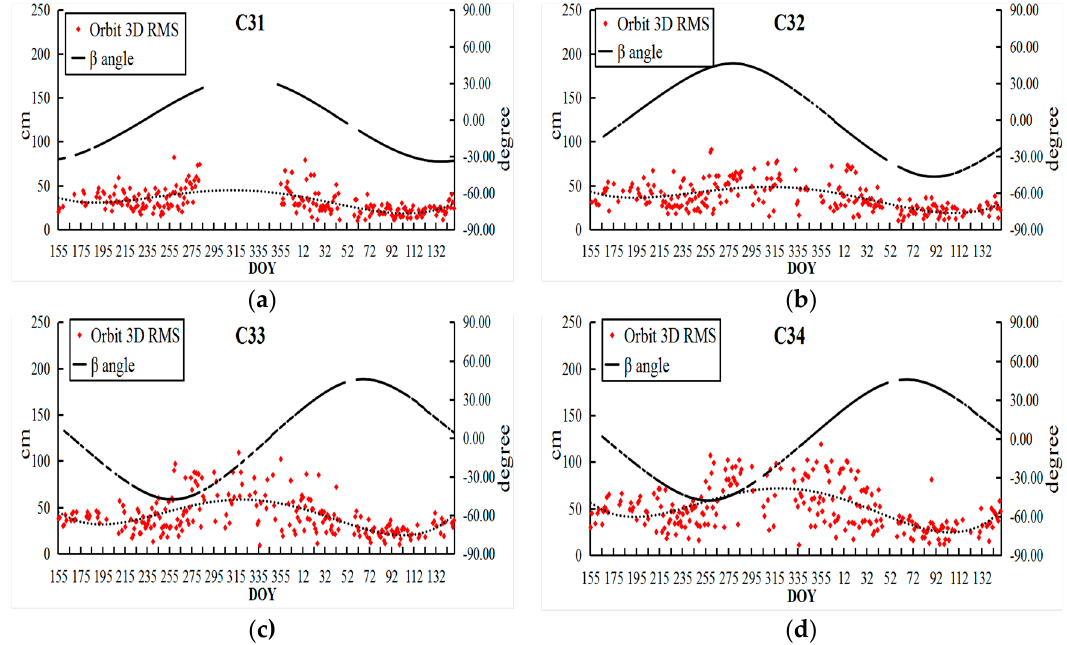
Figure 9. The 3D RMS of BDS-3 one-day overlapping arcs errors based on NES (( a ) C31; ( b ) C32; ( c ) C33; and ( d ) C34).